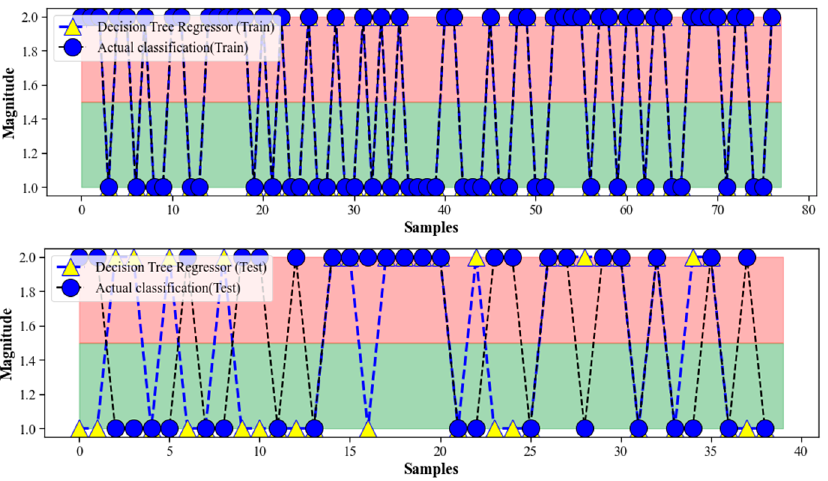
Figure 4. Both the training and testing data are used to demonstrate the process of detecting breast cancer using DTR. The procedure’s efficiency is evaluated using the training data, while its effectiveness is determined by analyzing its performance on the testing